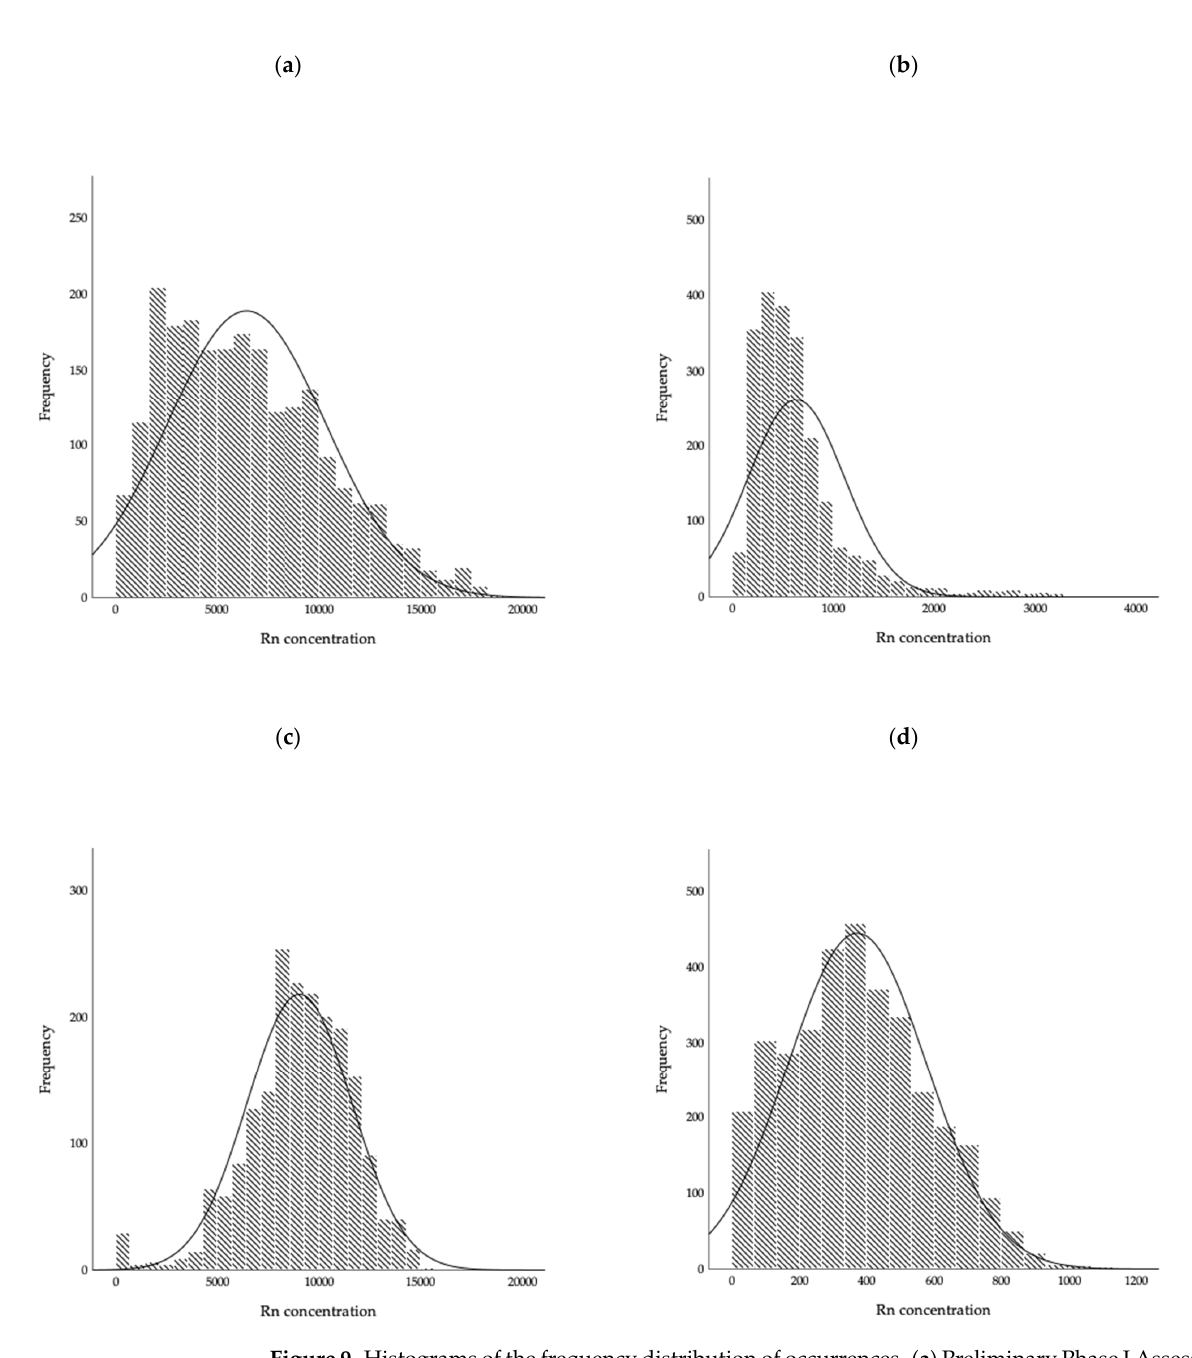
Figure 9. Histograms of the frequency distribution of occurrences. ( a ) Preliminary Phase I Assessment; ( b ) evaluation after application of the barrier membrane in Phase II(a); ( c ) evaluation after sealing the compartment door in Phase II(b); ( d ) evaluation after applying the coating mortar in Phase III.